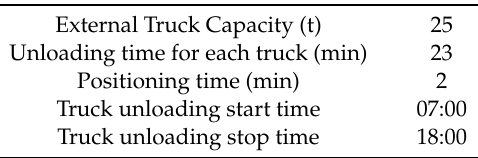
Table 2. Unloading data for P1.